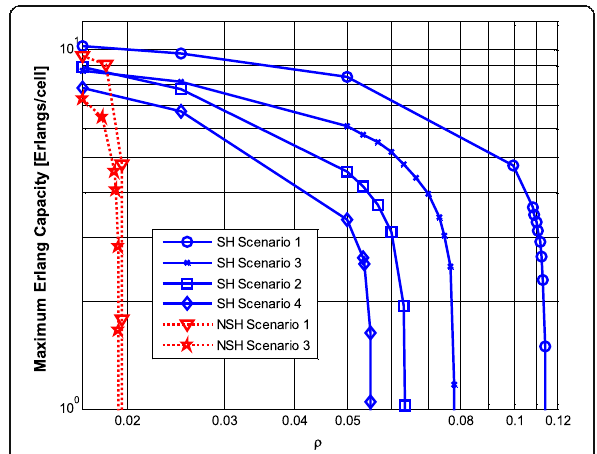
Fig. 8 Erlang capacity as a function of the utilization factor of the primary